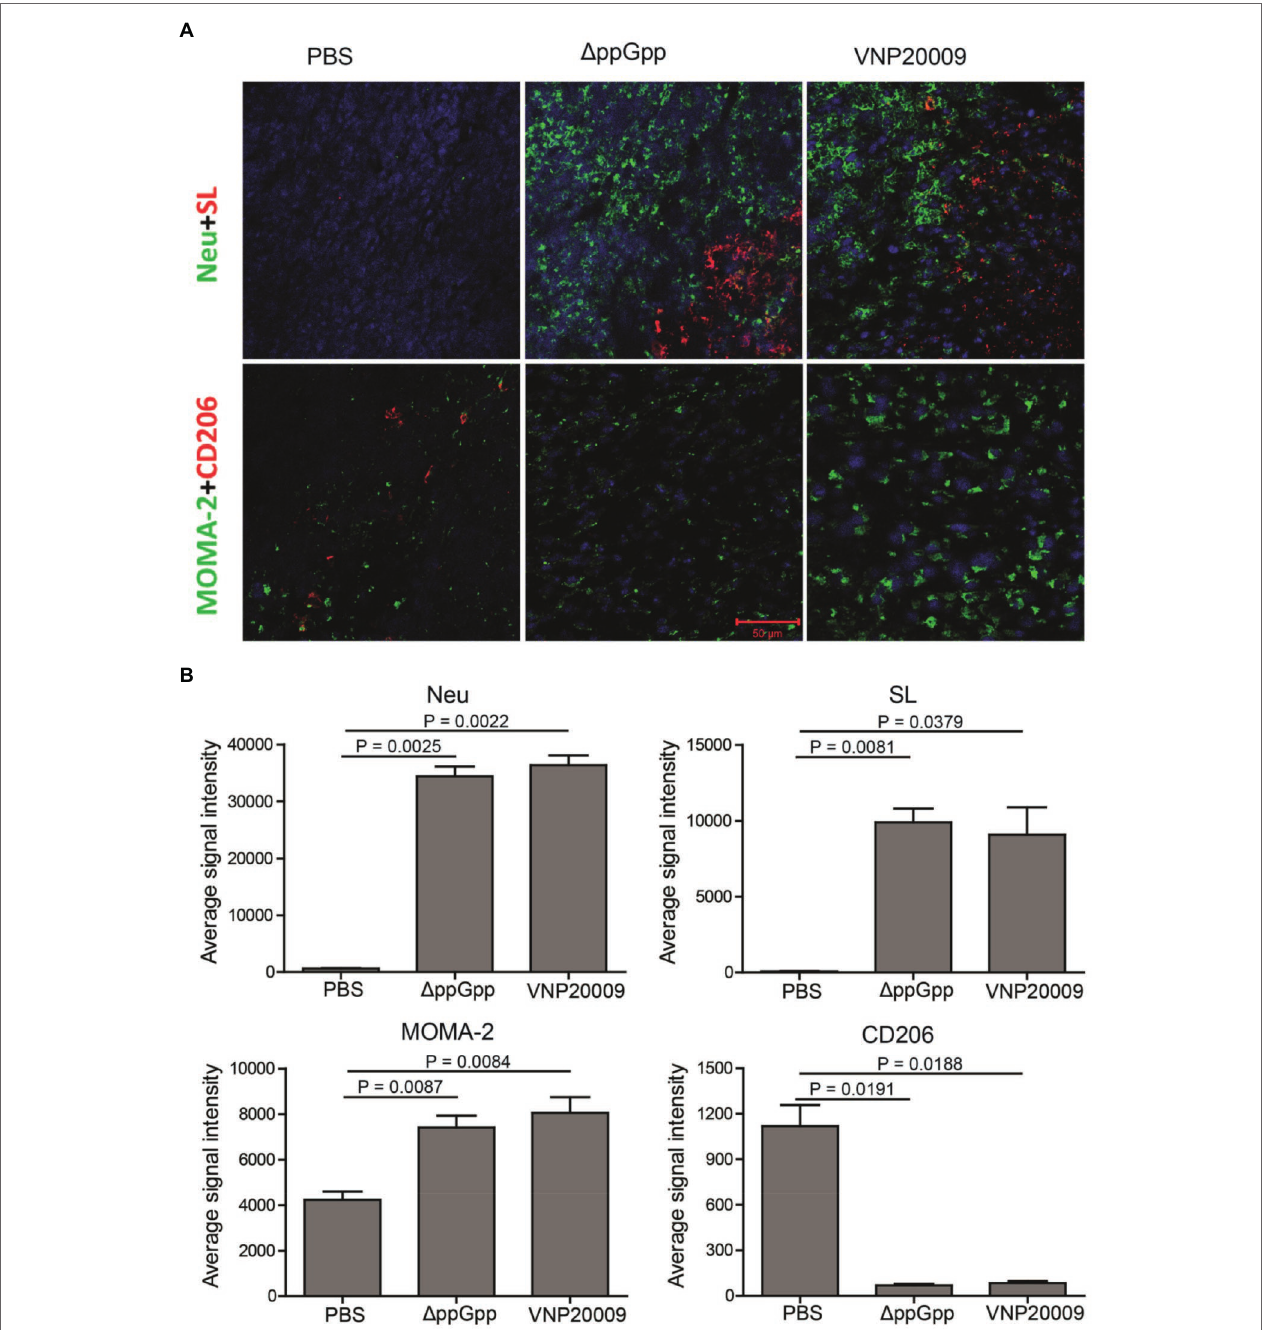
FIGURE 5 | Bacterial colonization and immune cell analysis in TMEs. (A) Three days after bacterial injection, immunofluorescence staining was performed on the tumor tissues of neutrophil (Neu, green), S. Typhimurium (SL, red), monocyte/macrophage (MOMA-2, green), and M2 macrophage (CD206, red). Scale bar = 50 μ m. (B) Quantification of the fluorescence intensity of neutrophils (Neu), Salmonella (SL), monocytes and macrophages (MOMA-2), M2-like macrophages (CD206), n = 4.